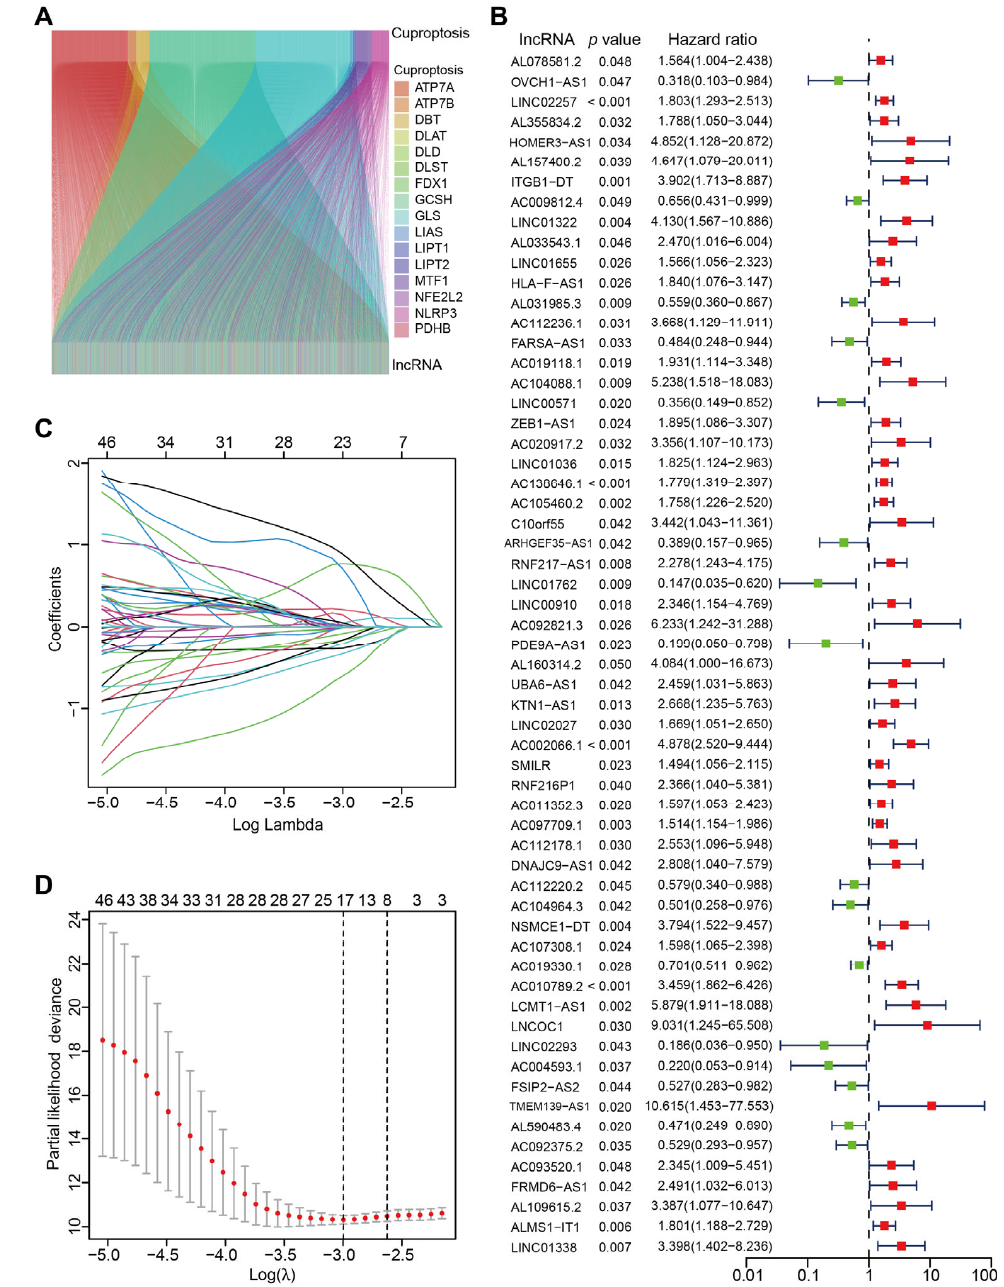
Figure 2. Identification of cuproptosis ‐ prognosis ‐ related LncRNAs. ( A ) Sankey diagram depicting the lncRNAs associated with cuproptosis ‐ related genes (|cor| > 0.4 and p < 0.001). ( B ) Forest plot demonstrating 60 CRLs associated with prognosis of CC patients ( p < 0.05). ( C ) Lasso coefficient of 60 CRLs associated with OS in CC patients. ( D ) The 60 CRLs based on LASSO cross validation plot. Table 1. Multivariate Cox results for cuproptosis ‐ related long non ‐ coding RNA based on The Can ‐ cer Genome Atlas—colon adenocarcinoma (TCGA ‐ COAD). Id Coef. HR